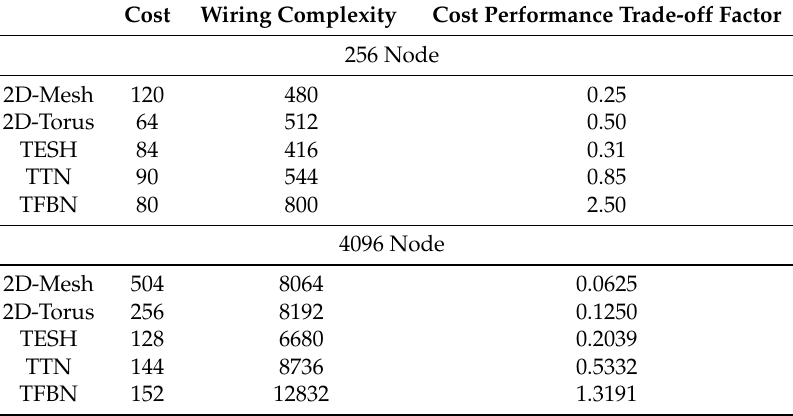
Table 2. Comparison of static cost, wiring complexity, and cost performance trade-off factor for various interconnection